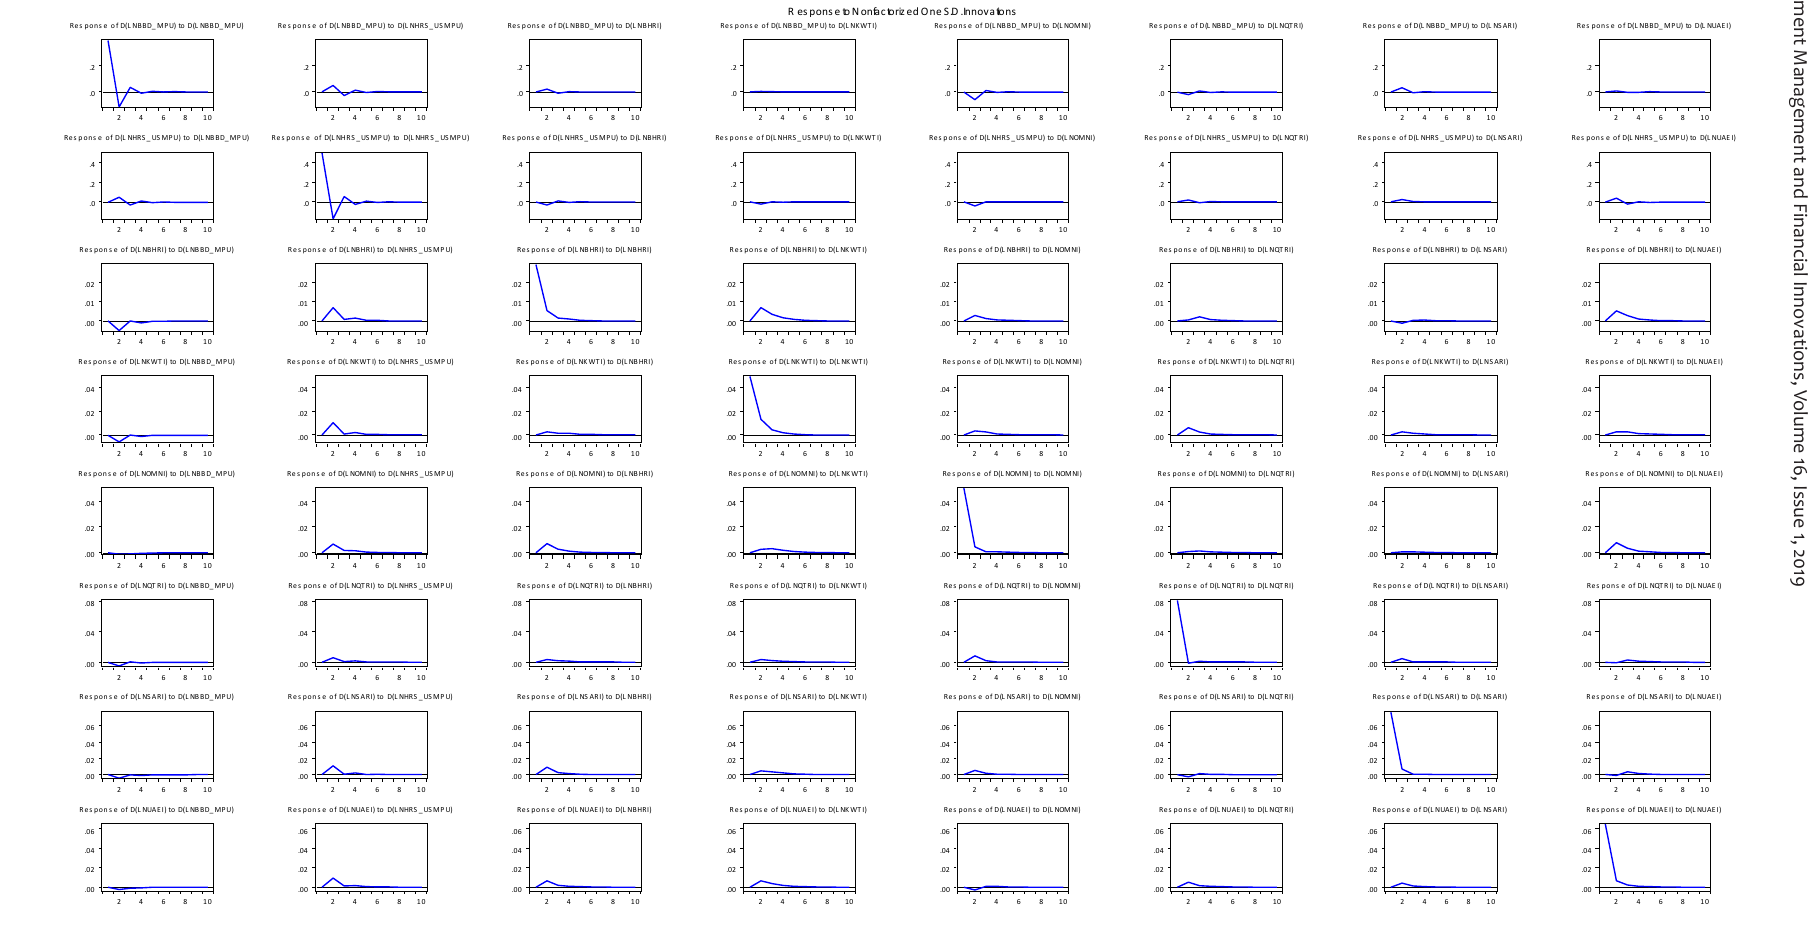
Figure 5. Residual test at one standard